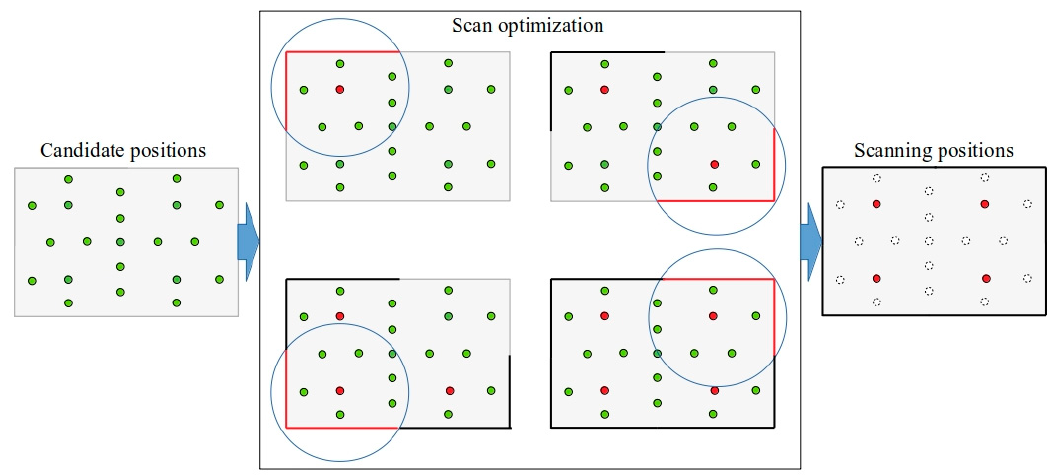
Figure 9. Scan optimization process is carried out from candidate positions (green points) to obtain scanning positions (red points). In each iteration the candidate position is selected which maximizes the theoretically acquirable surface (red lines). The black lines represent the surface theoretically acquired from the previously selected positions.